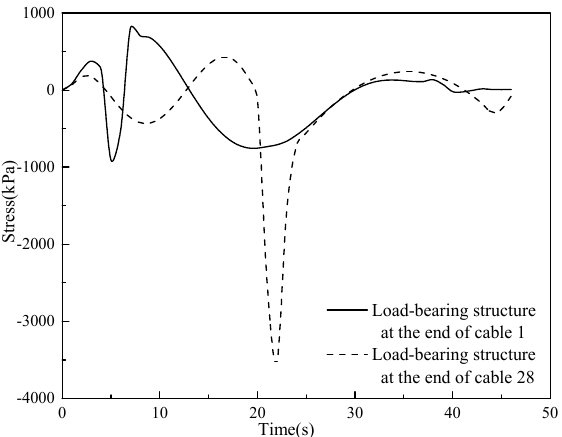
Figure 7. Time history of stress of load-bearing structures at the ends of cable 1 and cable 28.